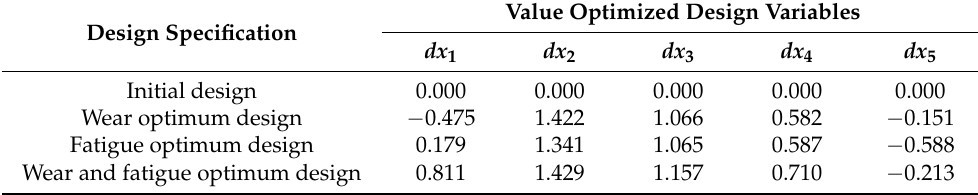
Table 2. Optimized design variables.